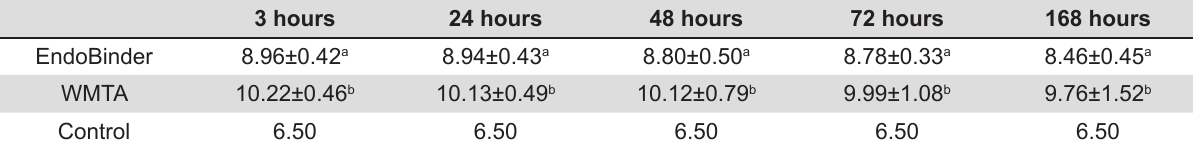
Table 2- Means and standard deviations of pH values at the different experimental times as well as statistical significance*